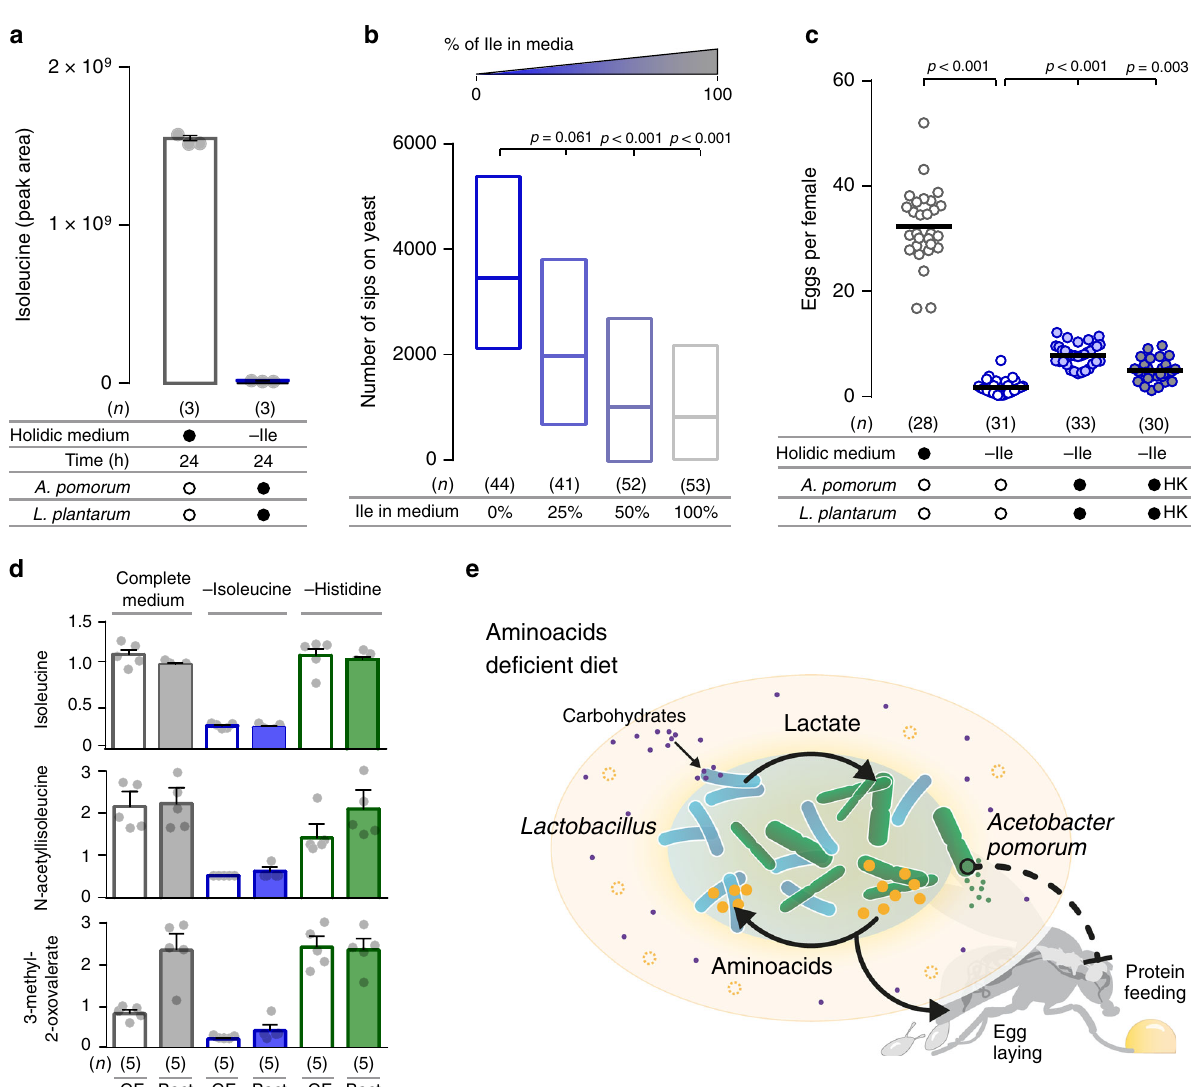
Fig. 6 Bacterial amino acid supply is unlikely to explain the effect of gut bacteria on behaviour. a Relative amount of total (labelled plus unlabelled) Ile determined by LC – MS in complete holidic medium without Ap and Lp and medium lacking Ile with Ap and Lp . Grey circles represent measurements in independent bacterial cultures ( n ), the column represents the mean, and error bars the s.e.m. b Number of sips on yeast of fl ies maintained in holidic medium lacking Ile (0%) or containing 25%, 50% or 100% of the Ile amount in complete medium. n represents the number of fl ies assayed per condition. Boxes represent median with upper and lower quartiles. c Each circle in the plot represents the number of eggs laid/female in single assays ( n ) and the line represents the mean. Females were fed complete holidic medium or medium lacking Ile treated with living or heat-killed (HK) bacteria. d Bars represent the relative abundance of Ile and Ile degradation metabolites in heads of germ-free fl ies (GF) and fl ies inoculated with commensal bacteria (Bact) and maintained in either complete medium, or medium lacking Ile or His. Grey circles represent measurements of metabolites in independent extracts of heads of fl ies ( n ), the column represents the mean and error bars the s.d. e Schematic describing the metabolic interactions between Ap and Lp and their potential effects on the bacterial community and the host. The absence of eAAs in the diet is represented as dashed circles. Black arrows represent the fl ow of Lp - produced lactate and its utilisation by Ap to produce AAs. These AAs are then used by Lp when dietary AAs are scarce. These are necessary for the bene fi cial effect of bacteria on egg laying. The black, dashed inhibitory arrow indicates the effect of Ap in suppressing host ’ s protein appetite through a yet undetermined lactate-dependent mechanism. In a , c black fi lled circles represent a complete holidic medium or association with bacterium. Open black circles represent the absence of bacterium. b , c Signi fi cance was tested using a Kruskal – Wallis test with Dunn ’ s multiple comparison test. Source data are provided as a Source Data fi